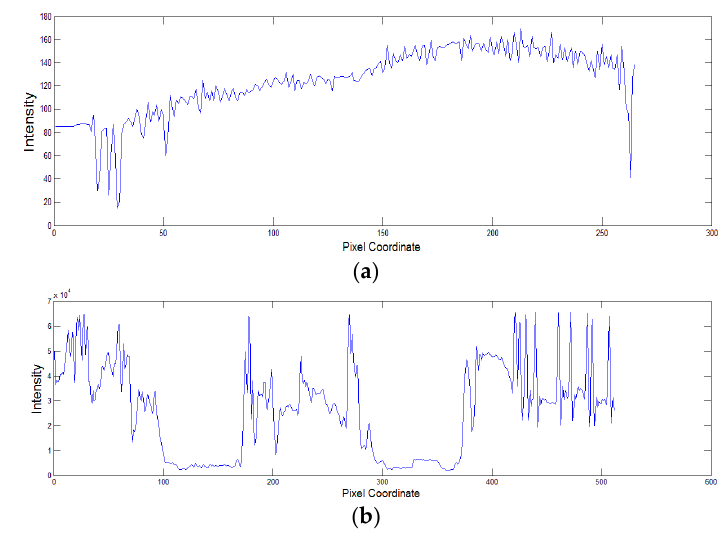
Figure 4. A single row extracted from: ( a ) text image; ( b ) book image.